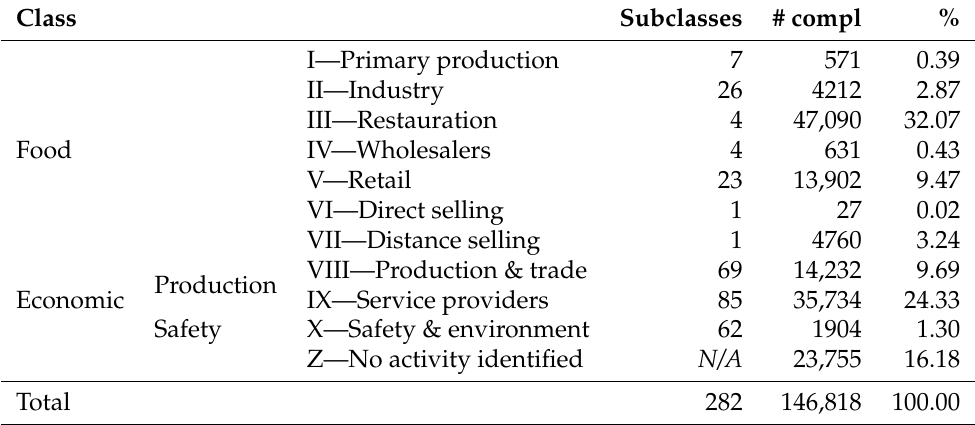
Table 1. Economic activity class hierarchy and